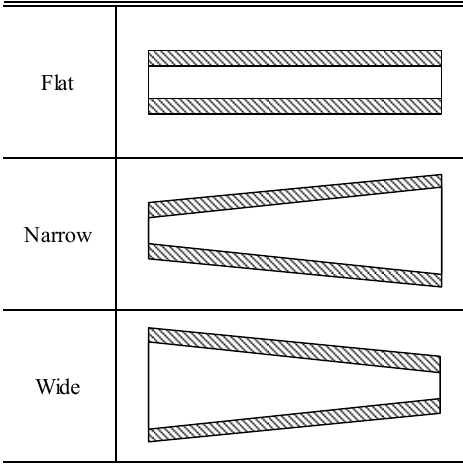
Figure 7. Longitudinal cross-sectional view of TSMD inlet.